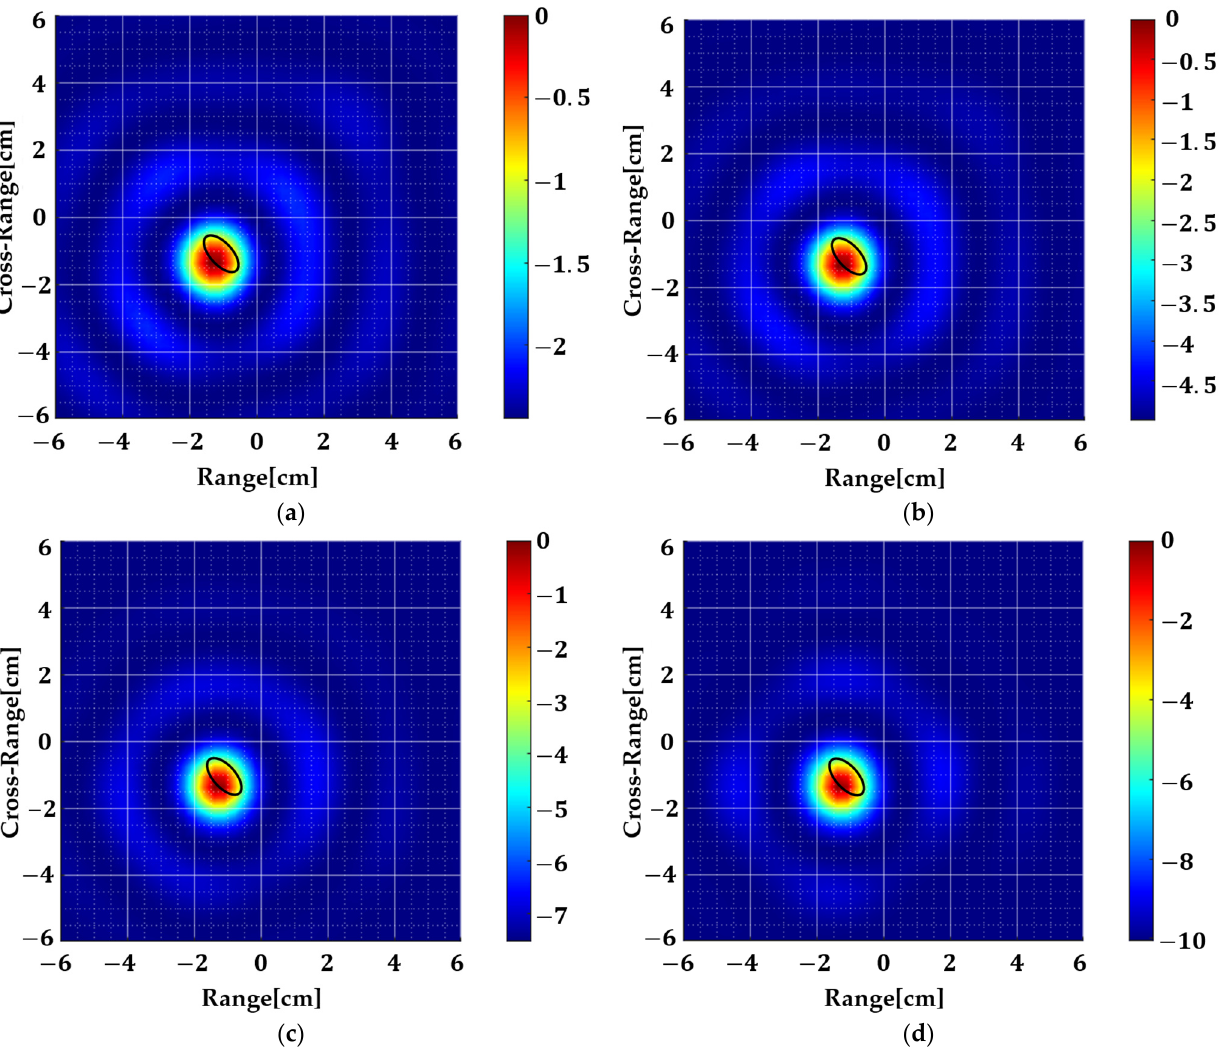
Figure 8. Simulated images of the geometry shown in Figure 7. The black ellipse is the true target location. ( a ) is the output of basic 2D MUSIC where m = M and n = N . ( b ) m = ( M − 2) and n = ( N − 2). ( c ) m = ( M − 4) and n = ( N − 4). ( d ) m = ( M − 6) and n = ( N − 6). By increasing the number of sub ‐ arrays, the dynamic range increases as shown in the color bar.